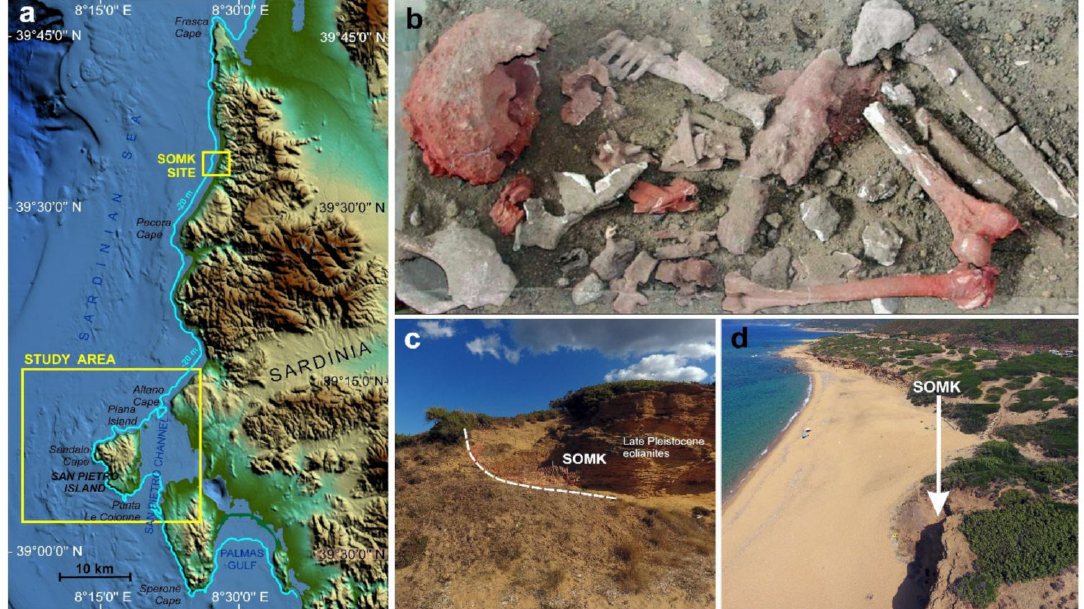
Figure 15. Mesolithic man in Sardinia west coast: ( a ) Location of S’Omu e S’Orku (SOMK) site and study area, palaeo- coastline of Mesolithic period (9 kyr BP) at 20 m. ( b ) The heavily ochre-stained skeletal remains (after Melis and Mussi, 2016 [81]). ( c ) View of SOMK Mesolithic site. ( d ) General view of the present-day position of Mesolithic SOMK site along the Sardinian west